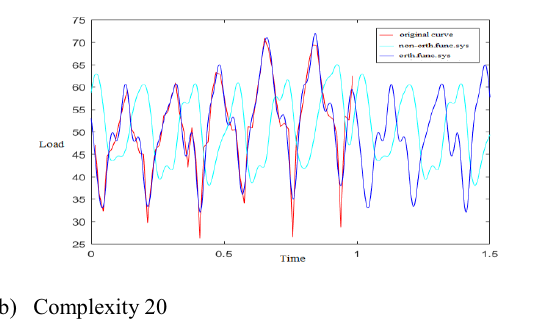
Figure 4. Fitting effect diagram for the two functional systems.